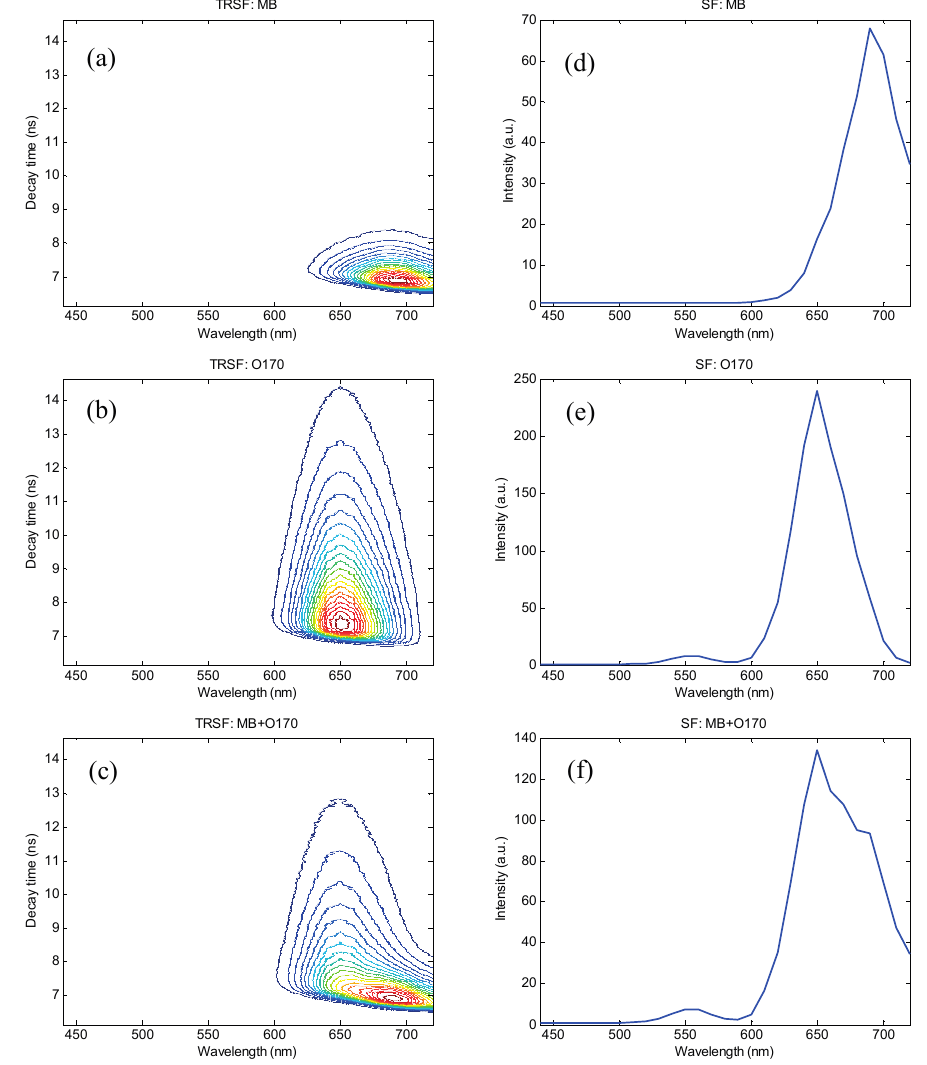
Figure 5. SF and TRSF spectra acquired using the TRSF system: linear contour plots of the TRSF spectra of ( a ) methylene blue (MB); ( b ) oxazine 170 (O170); ( c ) their mixture (MB + O170); and ( d – f ) SF spectra derived from the same data sets,